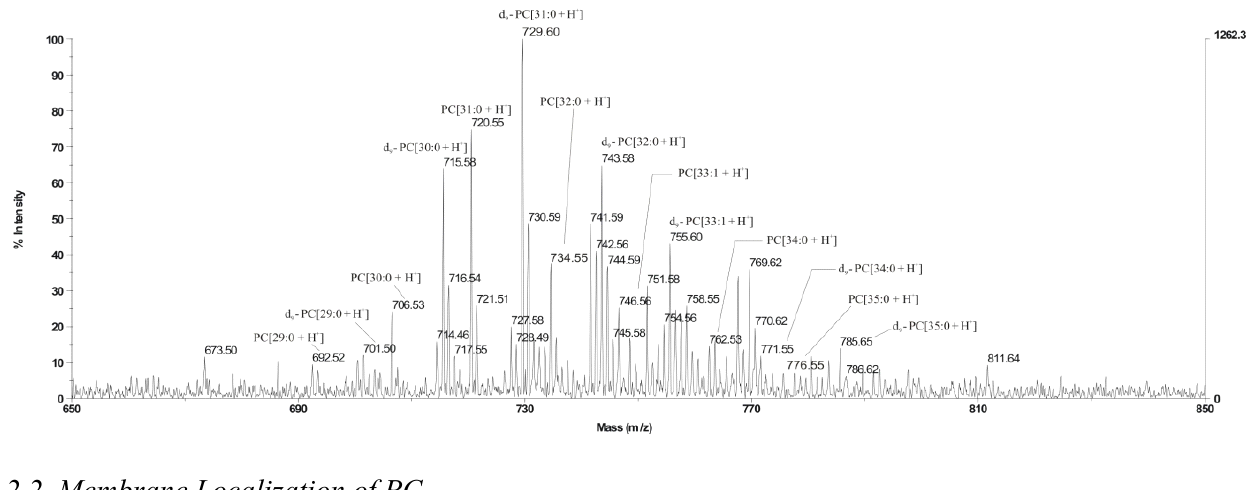
Figure 1. Positive ion mode MALDI-TOF spectrum of the PCs of L. dumoffii cultured on